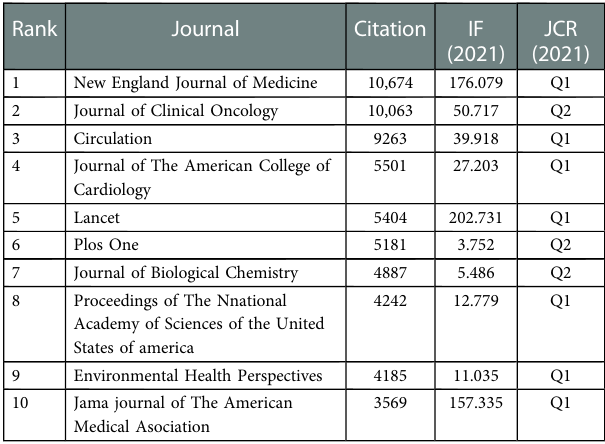
TABLE 5 Top 10 co-cited journals related to